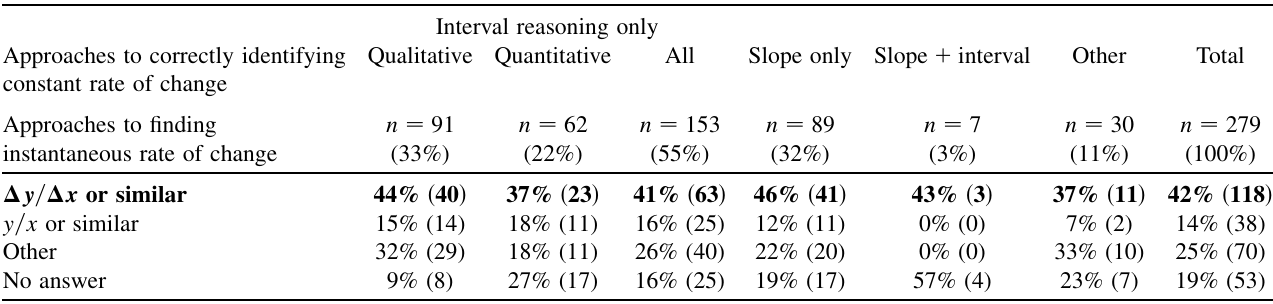
TABLE VI. Pretest results linking the reasons students gave for correctly identifying constant rate with how they determined a value for the rate of change at one particular instant. For an example of how to read the table, see the caption of Table II. Interval reasoning only Approaches to correctly identifying Qualitative Quantitative All Slope only Slope þ interval Other